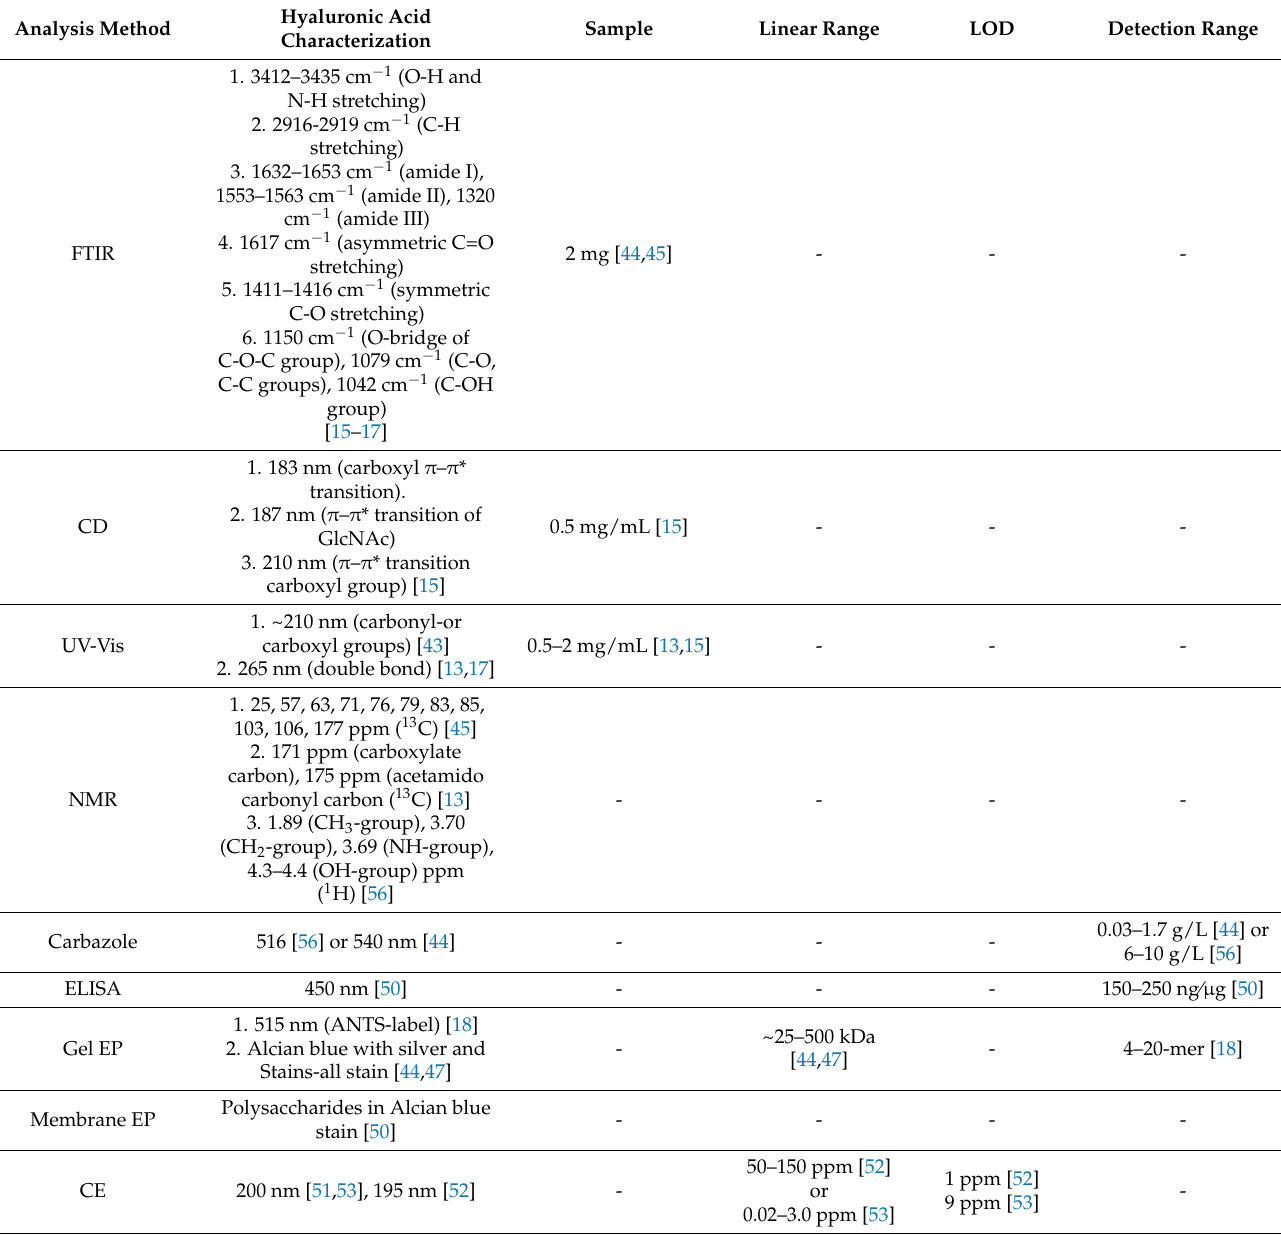
Table 1. Methods of analysis applied to hyaluronic acid